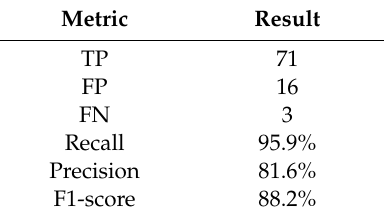
Table 9. Recognition result with audio